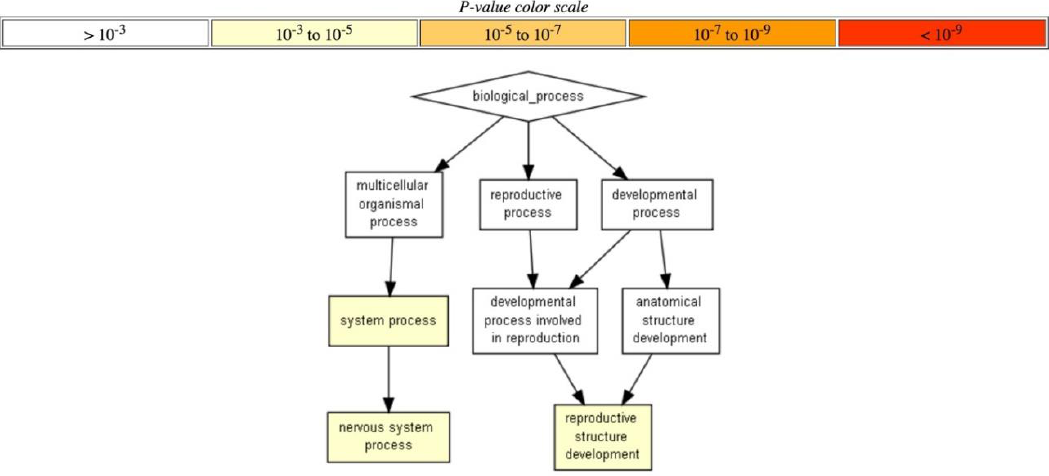
Figure 9. Hierarchically ordered GO annotated terms detected by Gorilla software for RRE-deficient genes for evolutionary young REs.